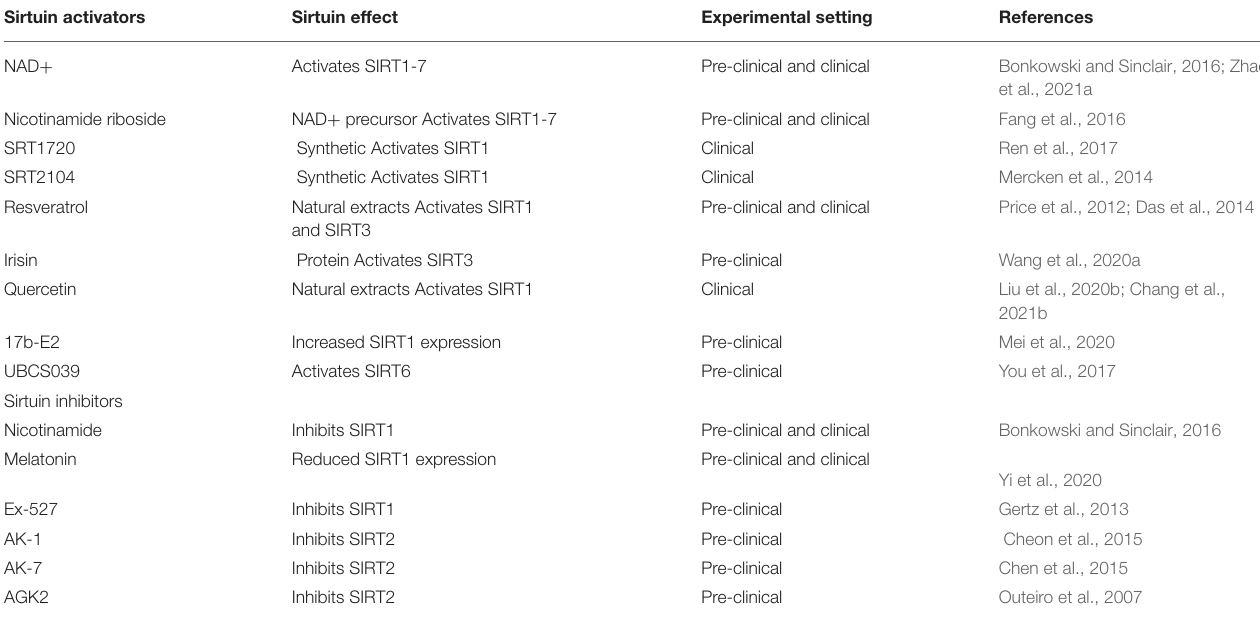
TABLE 2 | The modifiers of